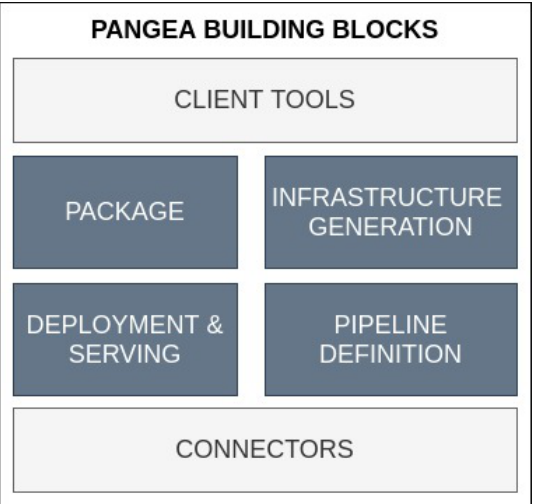
Figure 3. Pangea building blocks for the packaging, deploying, and serving of ML models; as well as for generating the required infrastructure.